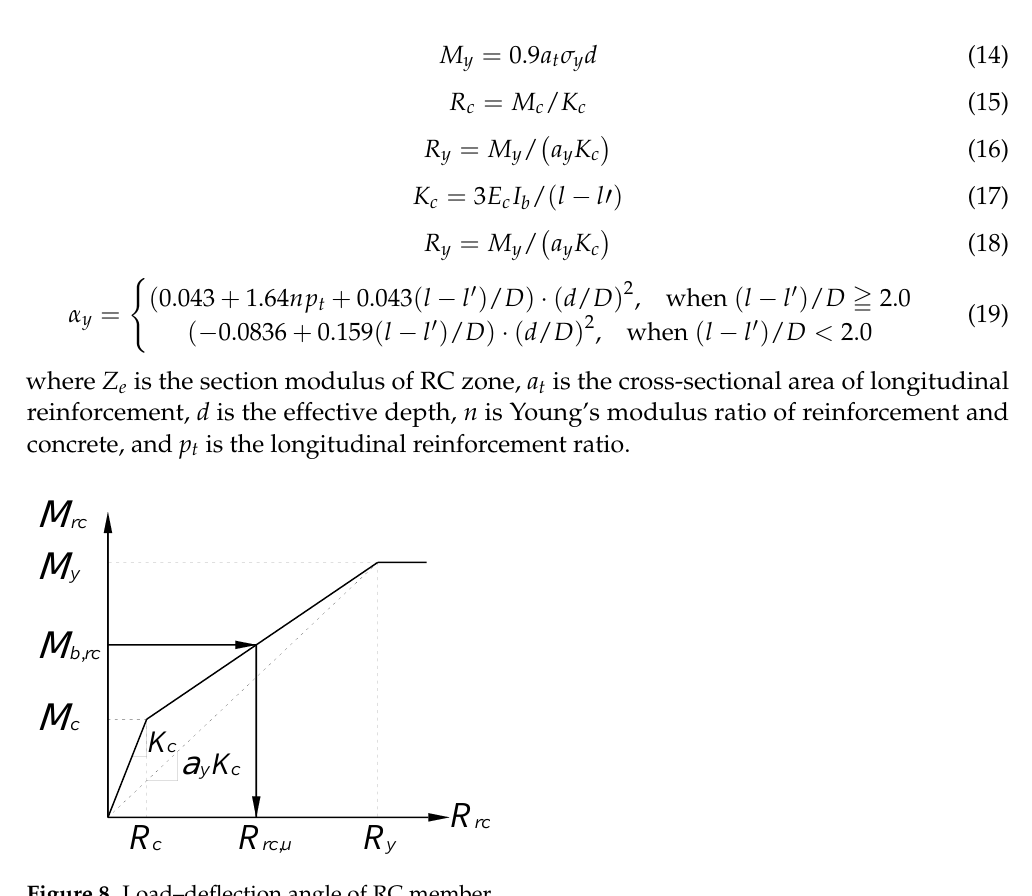
Figure 8. Load – deflection angle of RC member. Figure 8. Load–deflection angle of RC